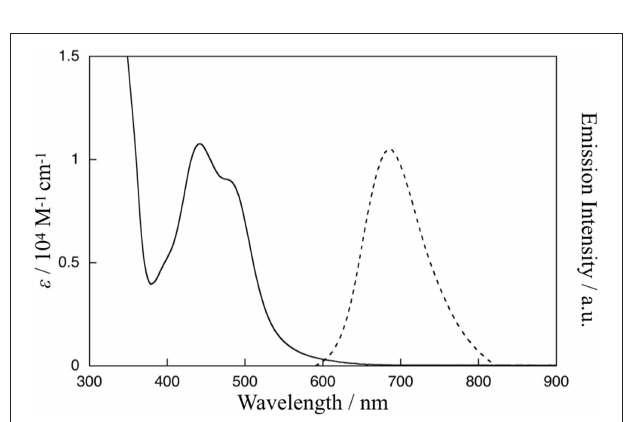
FIGURE 2 | Absorption spectrum (solid line) of 1 in CH 3 CN at 298K and emission spectrum (dotted line) of 1 in CH 3 CN at 298K upon excitation at